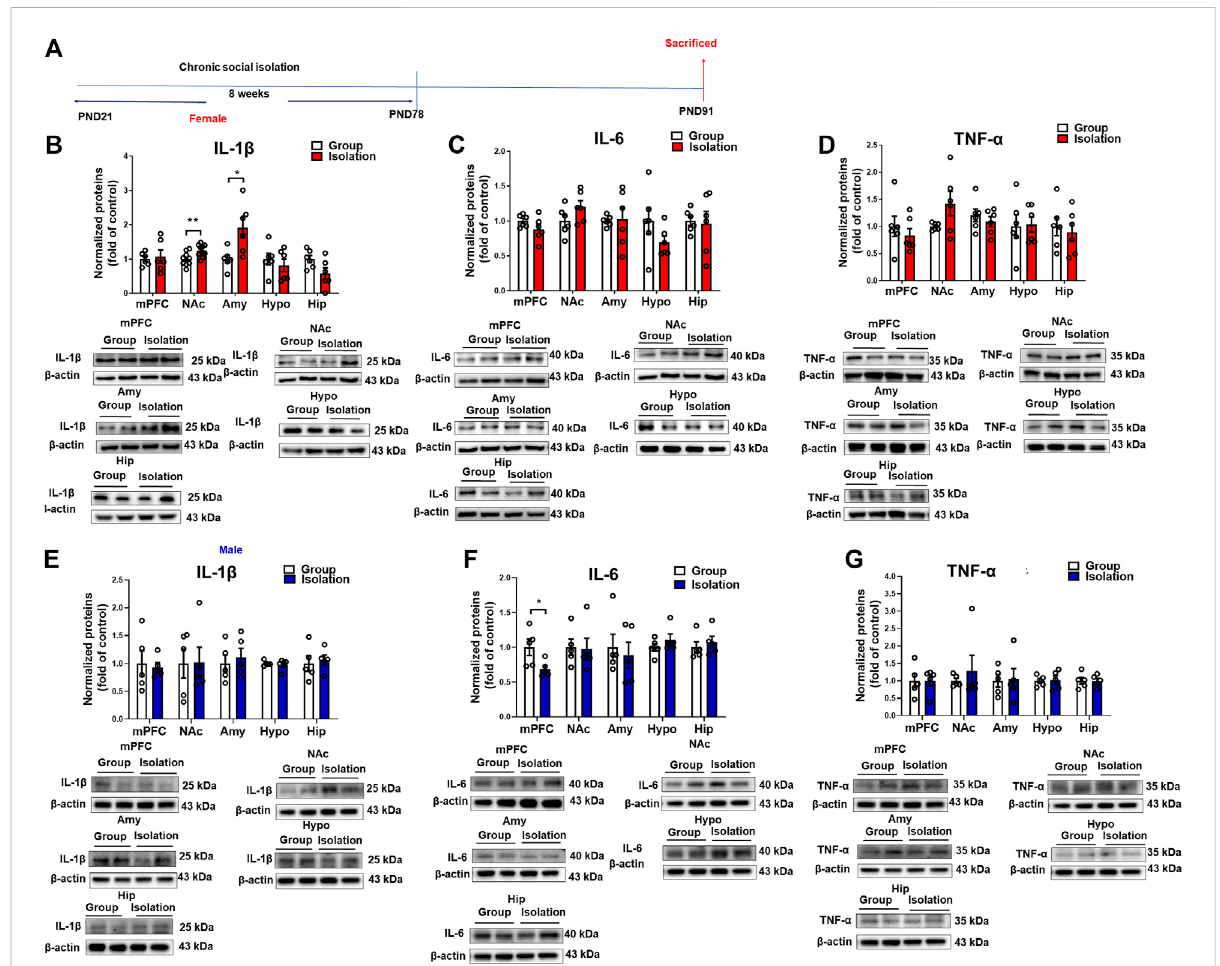
FIGURE 3 Childhood social isolation elevated neuroin fl ammation in amygdala in female mice. (A) Timeline of the experimental procedure. (B) The expressionsofIL-1 β , (C) IL-6, (D) TNF- α inthemPFC,NAc,Amy,HypoandHipoffemalemice(redbar, n =6)andrepresentativeimmunoblotsshown onthebottomofbargraphs. (E) TheexpressionsofIL-1 β , (F) IL-6, (G) TNF- α inthemPFC,NAc,Amy,HypoandHipofmalemice(bluebar, n =5)with representative immunoblots on the bottom of bar graphs. (H) Representative images of amygdala and subareas (BLA and CeA). Scale bar = 1 mm (location diagram of amygdala) and 100 μ m (partial schematic diagram). (I) Representative images of Iba-1 (a microglia marker) staining in amygdala,scalebar=20 μ m(bottom). (J,K) SocialisolationincreasedmicrogliainBLAbut notinCeA, n =3.Dataweremean± SEM,* p < 0.05,** p